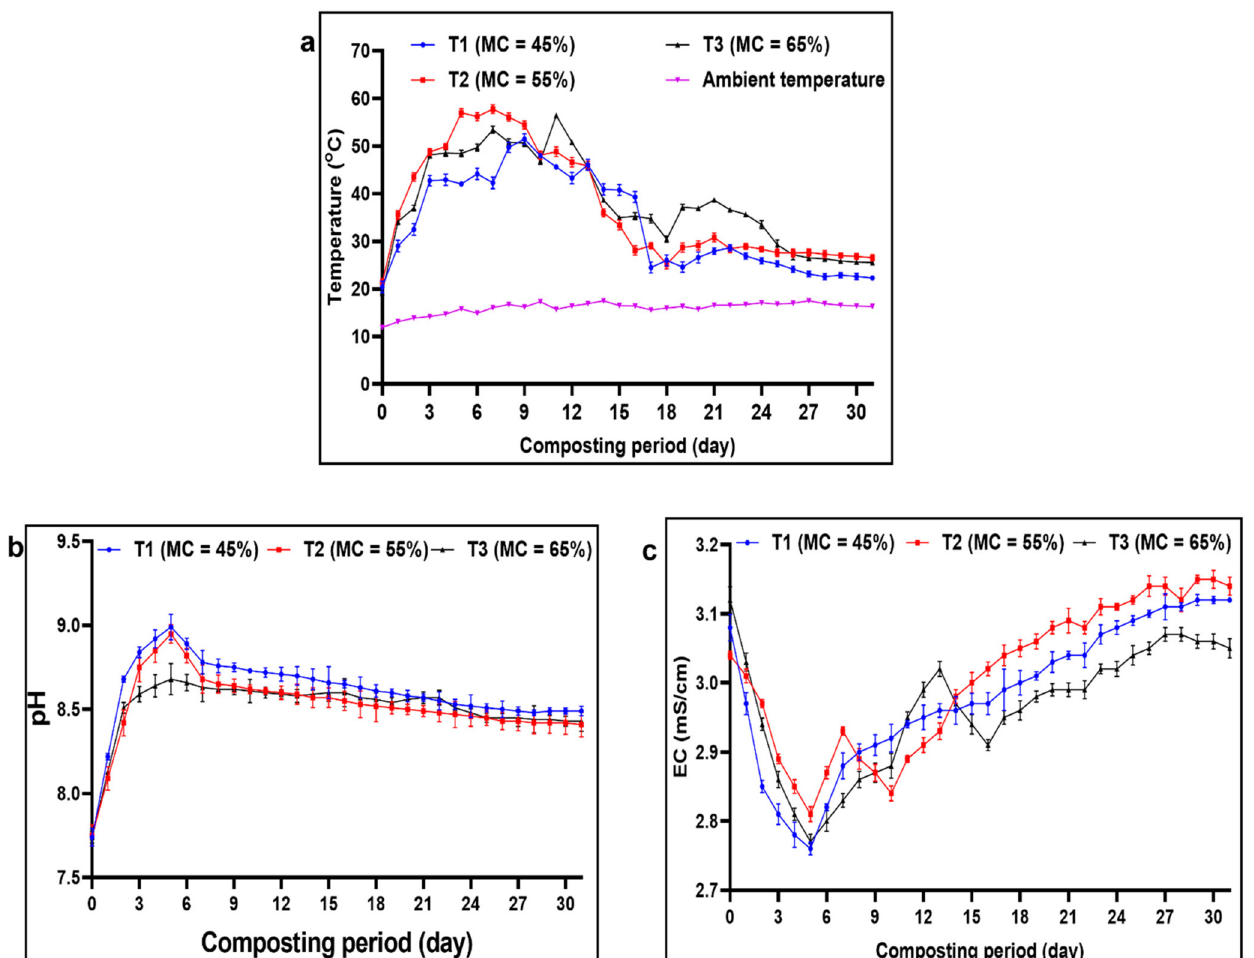
Figure 2. Evolutionary dynamics of temperature ( a ), pH ( b ) and EC ( c ) during composting under different moisture